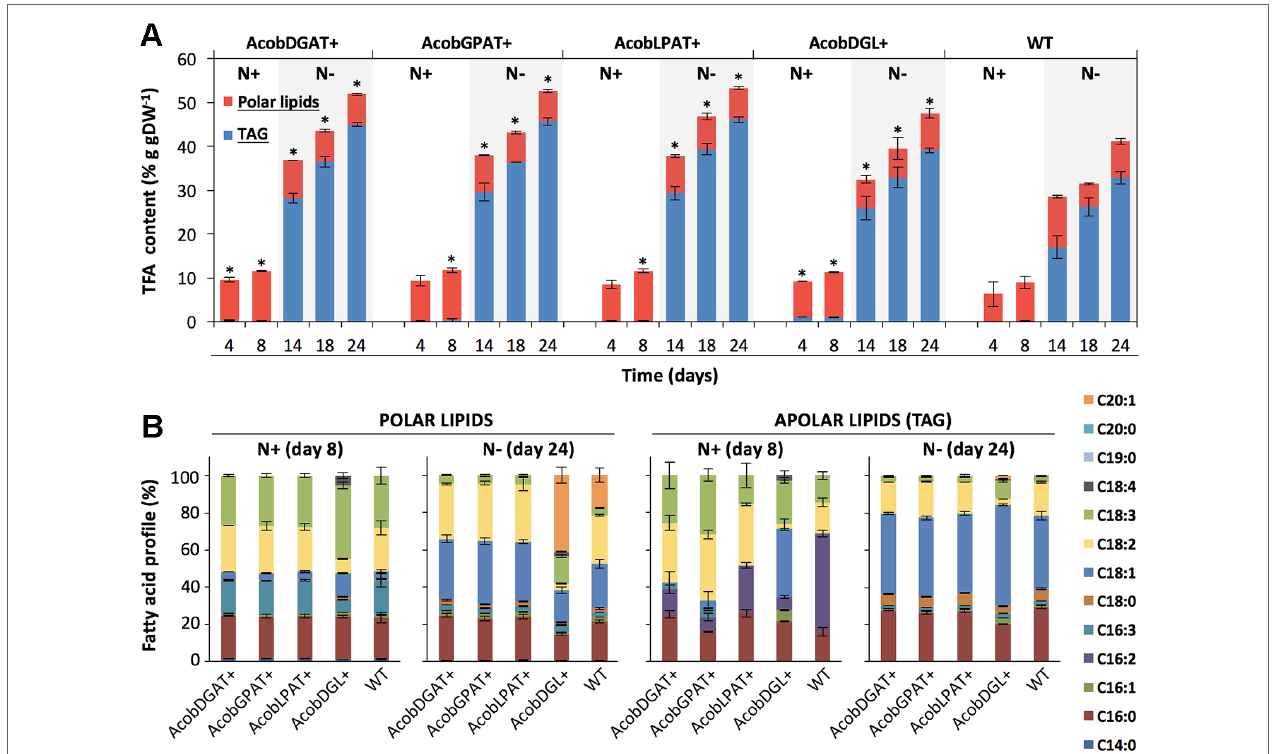
FigUrE 4 | Total fatty acid (TFA), triacylglycerols (TAG), and fatty acid composition in N. oleoabundans wild type strain and transformant lines. Total fatty acids: TAG and polar lipids (A) . Polar and apolar lipid (TAG) composition at days 8 and 24 during nitrogen replete (N+) and depleted (N-) nitrogen conditions, respectively (B) . The data represent the average of n = 3 replicate experiments. Standard deviation bars are shown. Significant difference between wild type strain and transformant lines is indicated at P < 0.05